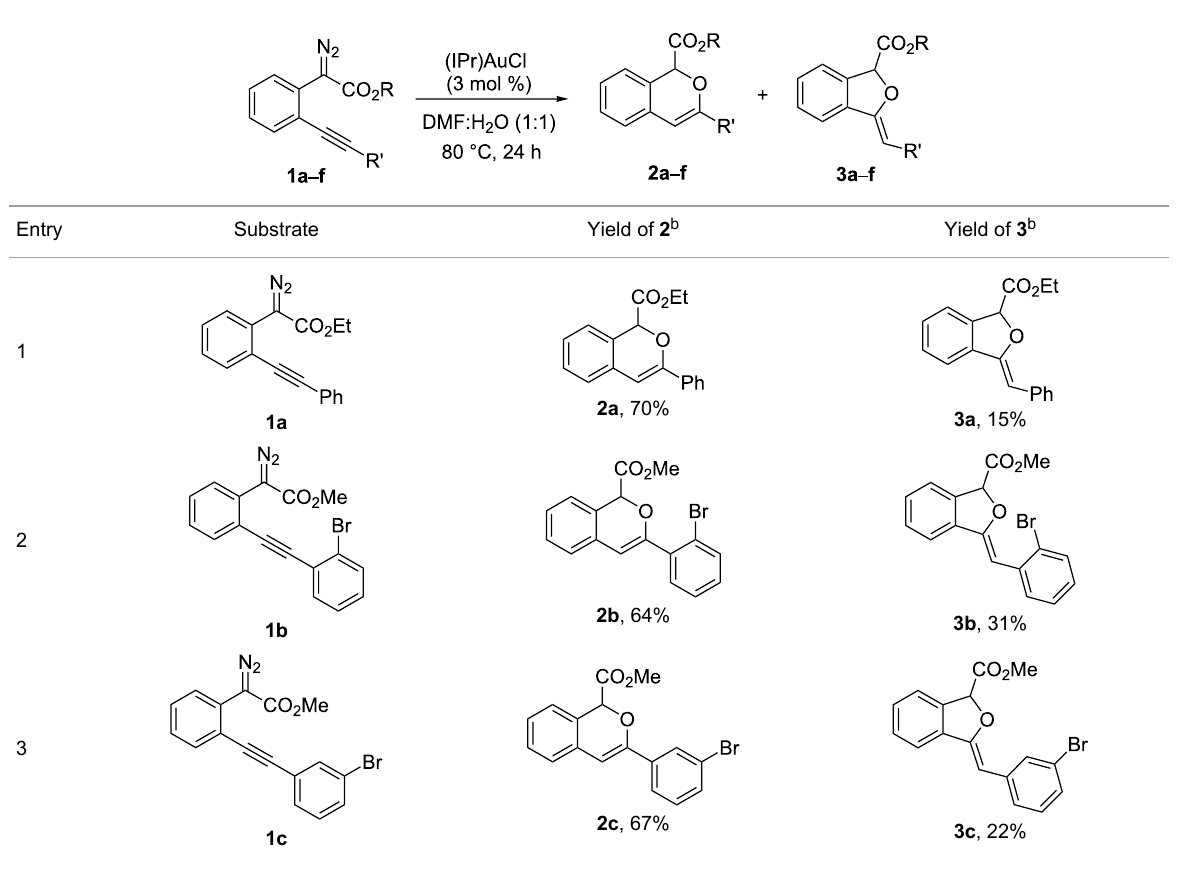
Table 2: Gold(I)-catalyzed cascade insertion/cyclization of water with various substituted phenyldiazoacetates a .